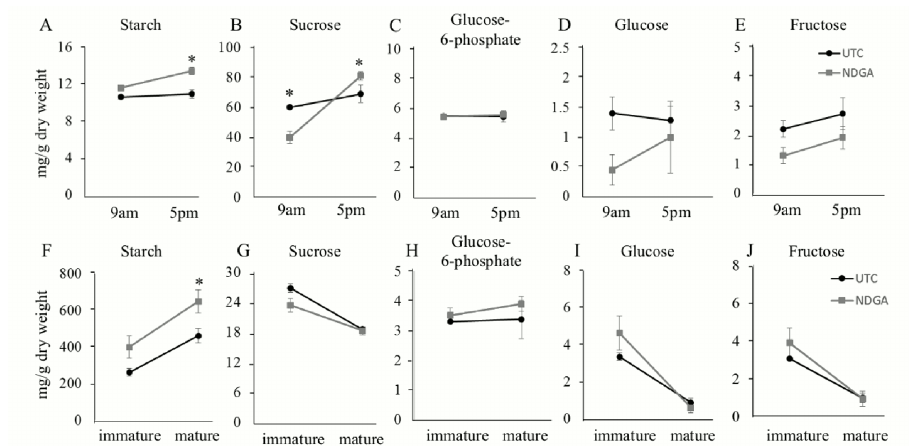
Fig 2. Starch and sugars contents in source and sink tissues treated with ABA biosynthesis inhibitor. Starch (A,F), Sucrose (B,G), Glucose-6-phosphate (C,H), Glucose (D,I), Fructose (E,J) contents in flag leaves (A-E) and immature/mature grains (F-J) treated with UTC and NDGA at pre-anthesis stage. Values are Mean ± SE (n = 4). * indicates significance at P (cid:3) 0 . 05